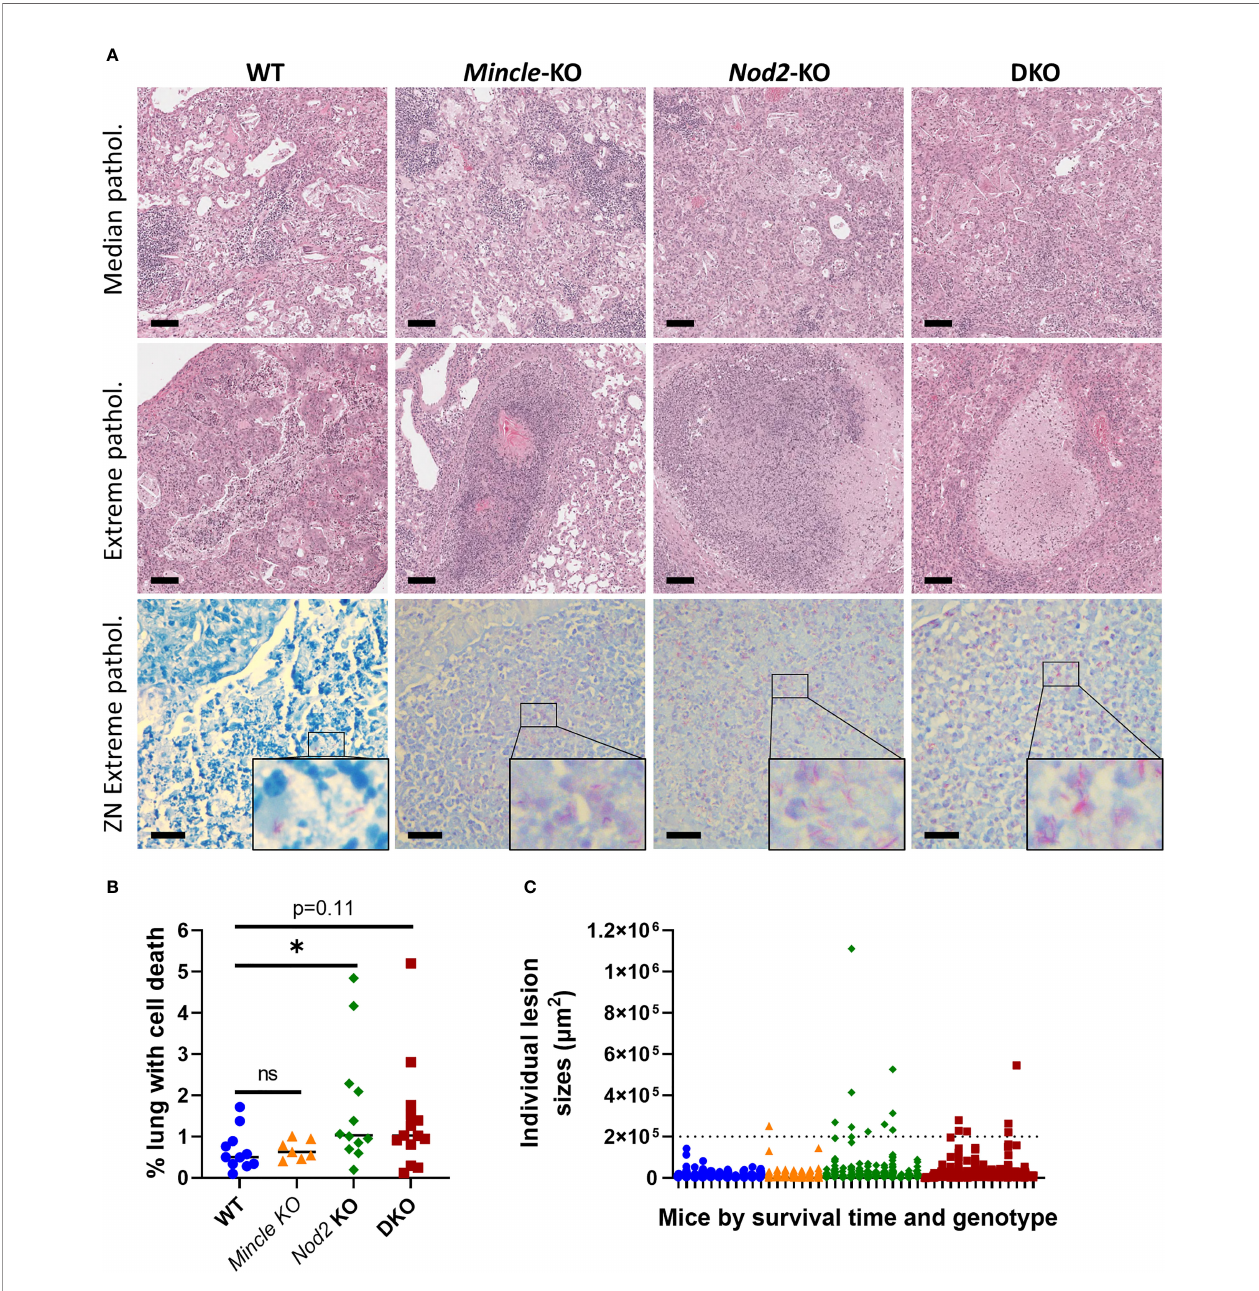
FIGURE 5 | Pulmonary pathology at death in Mincle and Nod2 de fi cient mice infected with Mtb . (A) , representative images of H&E-stained sections showing median pathology by genotype (top row), largest lesions containing cell death by genotype (middle row, center of images, including necrotizing foci for Nod2 - de fi cient animals) and ZN-stained sections corresponding to lesions in middle (bottom row, with enlarged inset to show AFB). Scale bars for H&E and ZN are 100 m m and 20 m m, respectively. (B) , percentage of lung space containing dead cells with medians. Groups were signi fi cantly different by a Kruskal-Wallis test: p = 0.0424. Shown in the panel are the results of Dunn ’ s multiple comparisons test for comparison of Mincle -KO, Nod2 -KO and DKO to WT; ns, not signi fi cant (p > 0.05); *p = 0.0486. (C) sizes of individual lesions containing dead cells, separated by mouse according to genotype (colour/shape-coded) and in order of survival time (left to right, shortest to longest). Dotted line delineates lesions larger than 0.2 mm 2 . N = 11, 7, 12 and 14 for WT, Mincle -KO, Nod2 -KO and DKO,